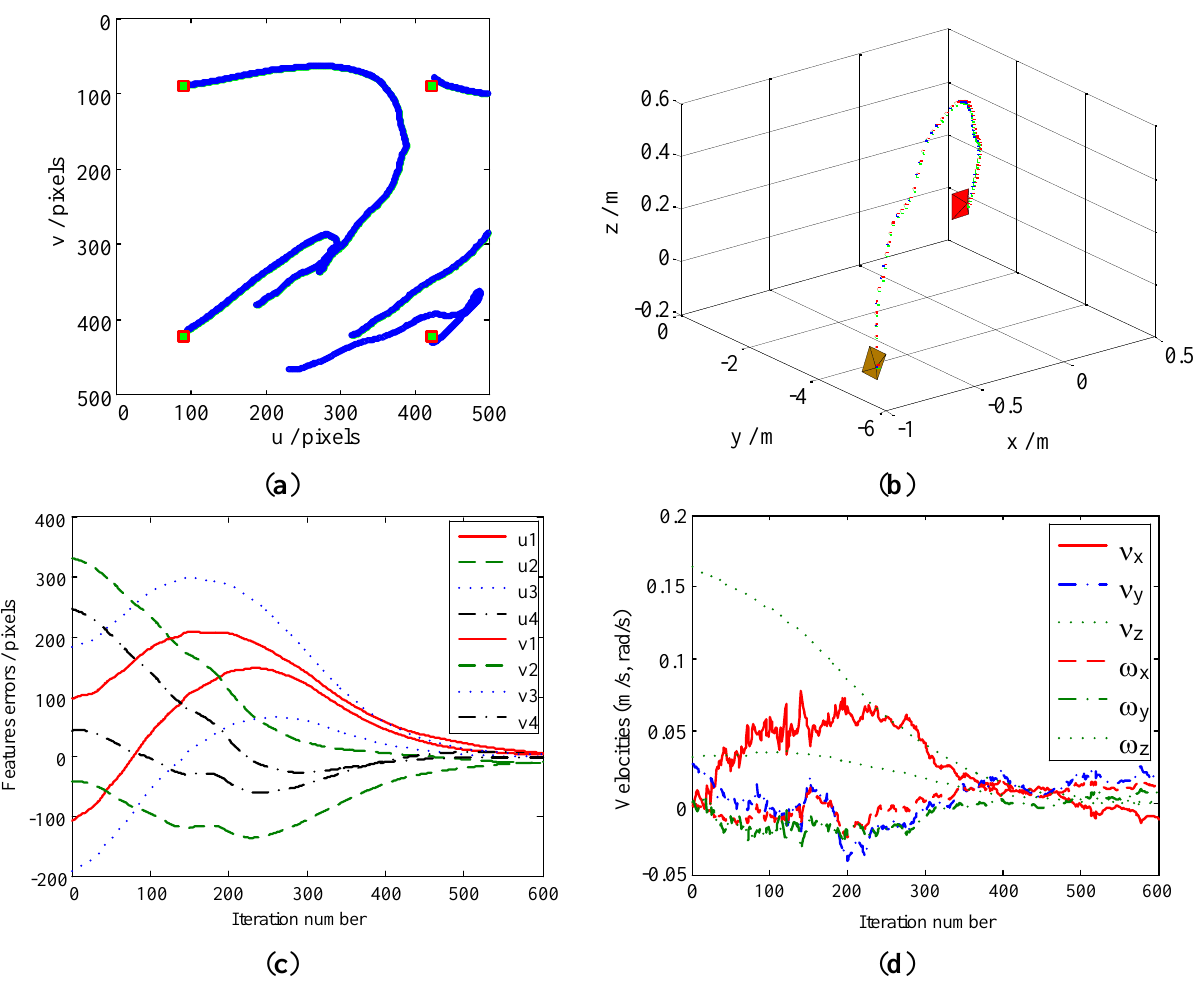
Figure 11. Results obtained by the KBF method for Case 4. ( a ) Feature trajectories; ( b ) Camera trajectory; ( c ) Feature errors; ( d ) Camera